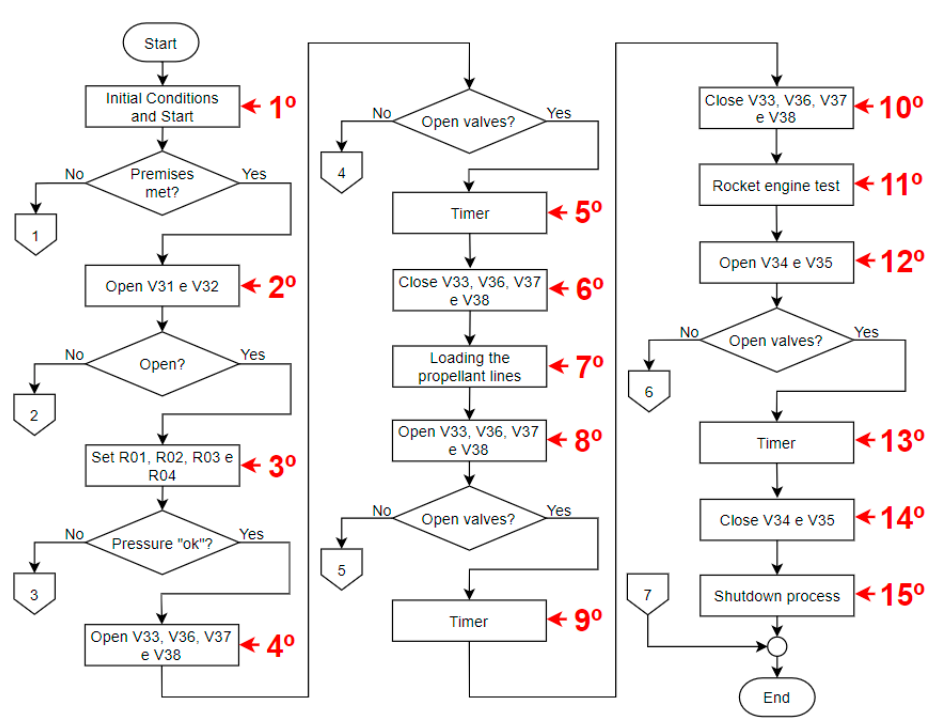
Figure 3. Purge algorithm flowchart.